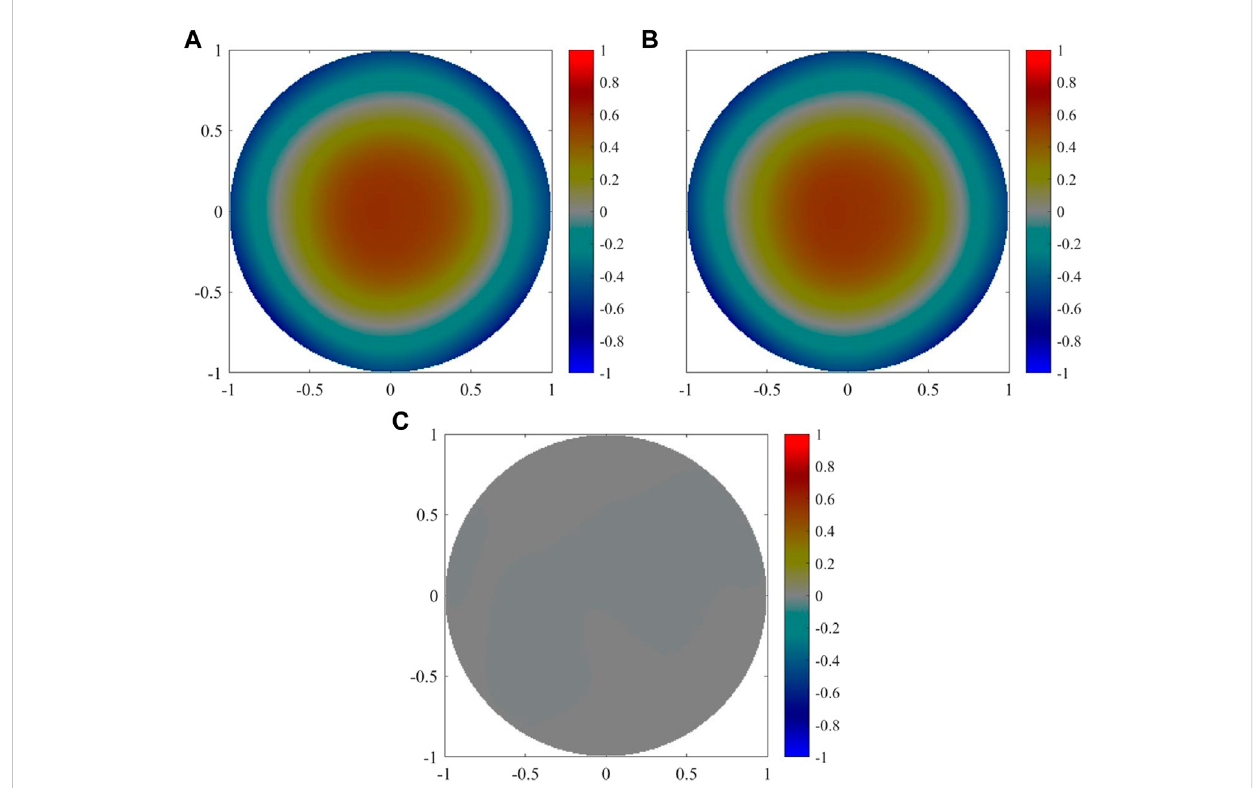
FIGURE 7 Comparison of wavefront detection results between traditional method (A) and p-SHWFS (B) under without stray light, (C) the wavefront residual error between the two methods.